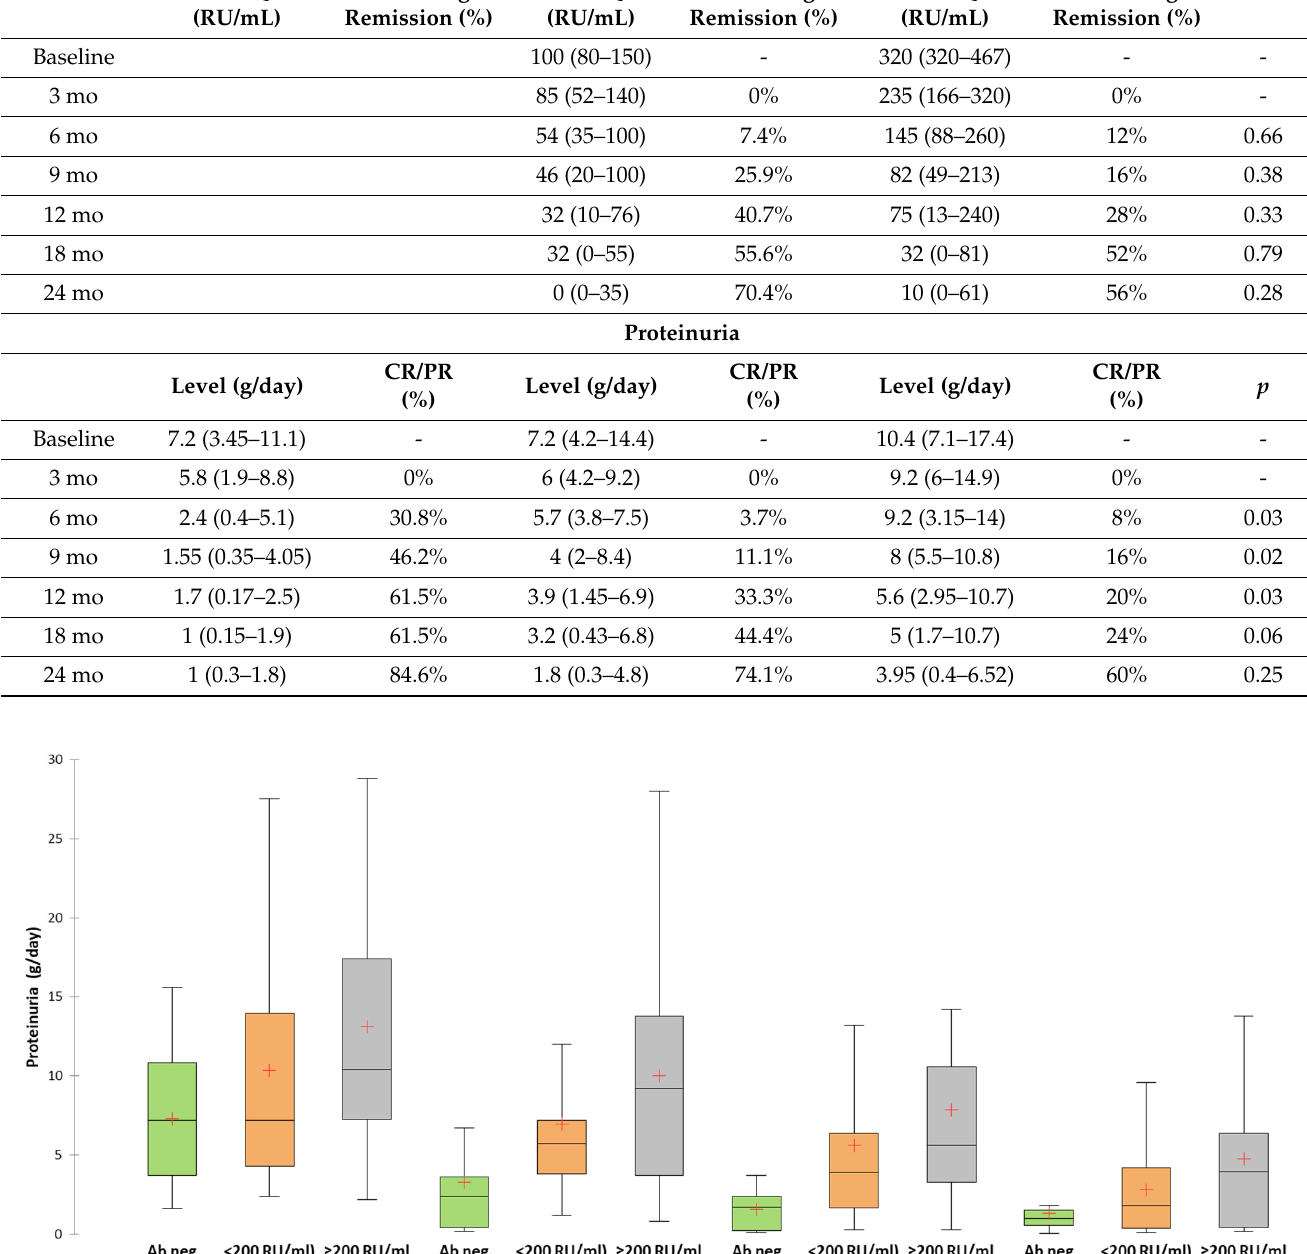
Table 2. Evolution of sPLA2R-ab titer and 24-h proteinuria according to baseline anti-PLA2R antibody status .